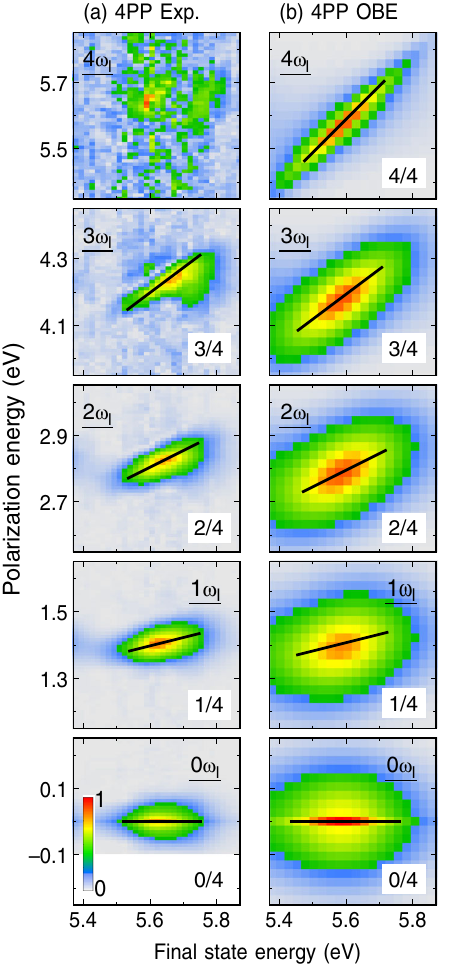
FIG. 7. 2D-FT photoelectron spectral components showing the SS state signal generated by a Fourier analysis (a) of the ITR-4PP experiment in Fig. 6 and (b) a five-level OBE simulation. The color range of each 2D spectrum is scaled independently. FT amplitudes disperse with final state and polarization energy. The tilt is highlighted by black lines, and their slopes are quantified in the white